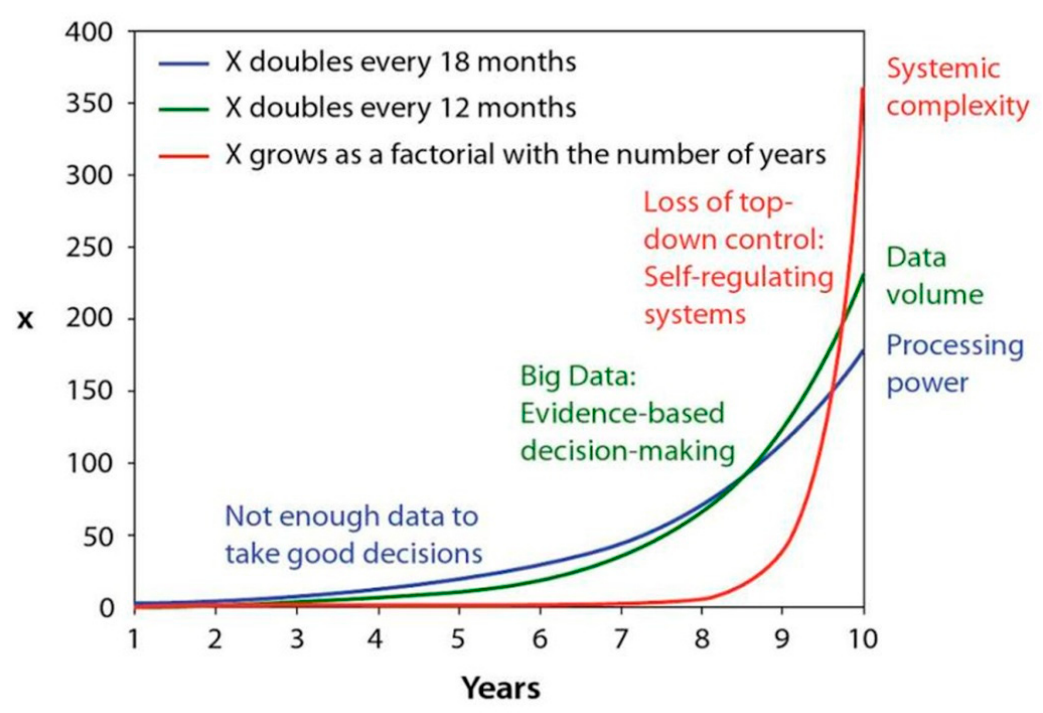
Figure 5. Helbing et al.’s [117] model for digital growth comparing computational and data resources with systemic complexity to analyze data.